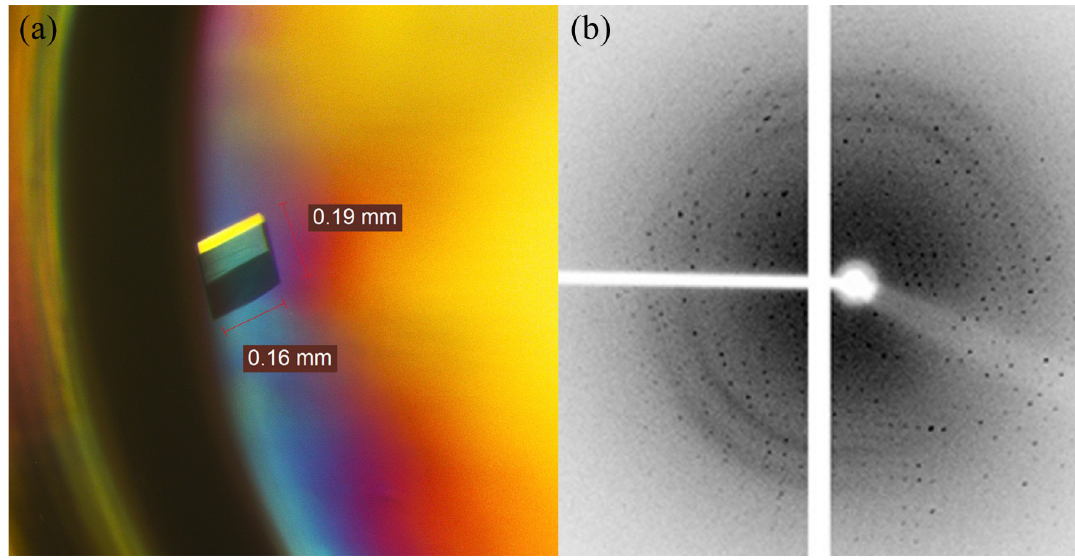
Fig 3. 5M mutant diffraction analysis. (a) 5M mutant crystal structure formed in the formulation of 0.5 M sodium cacodylate trihydrate and 0.4 M sodium citrate tribasic pH 6.5 supplemented with 0.2 M NaCl. (b) Diffraction image of 5M mutant lipase crystal.